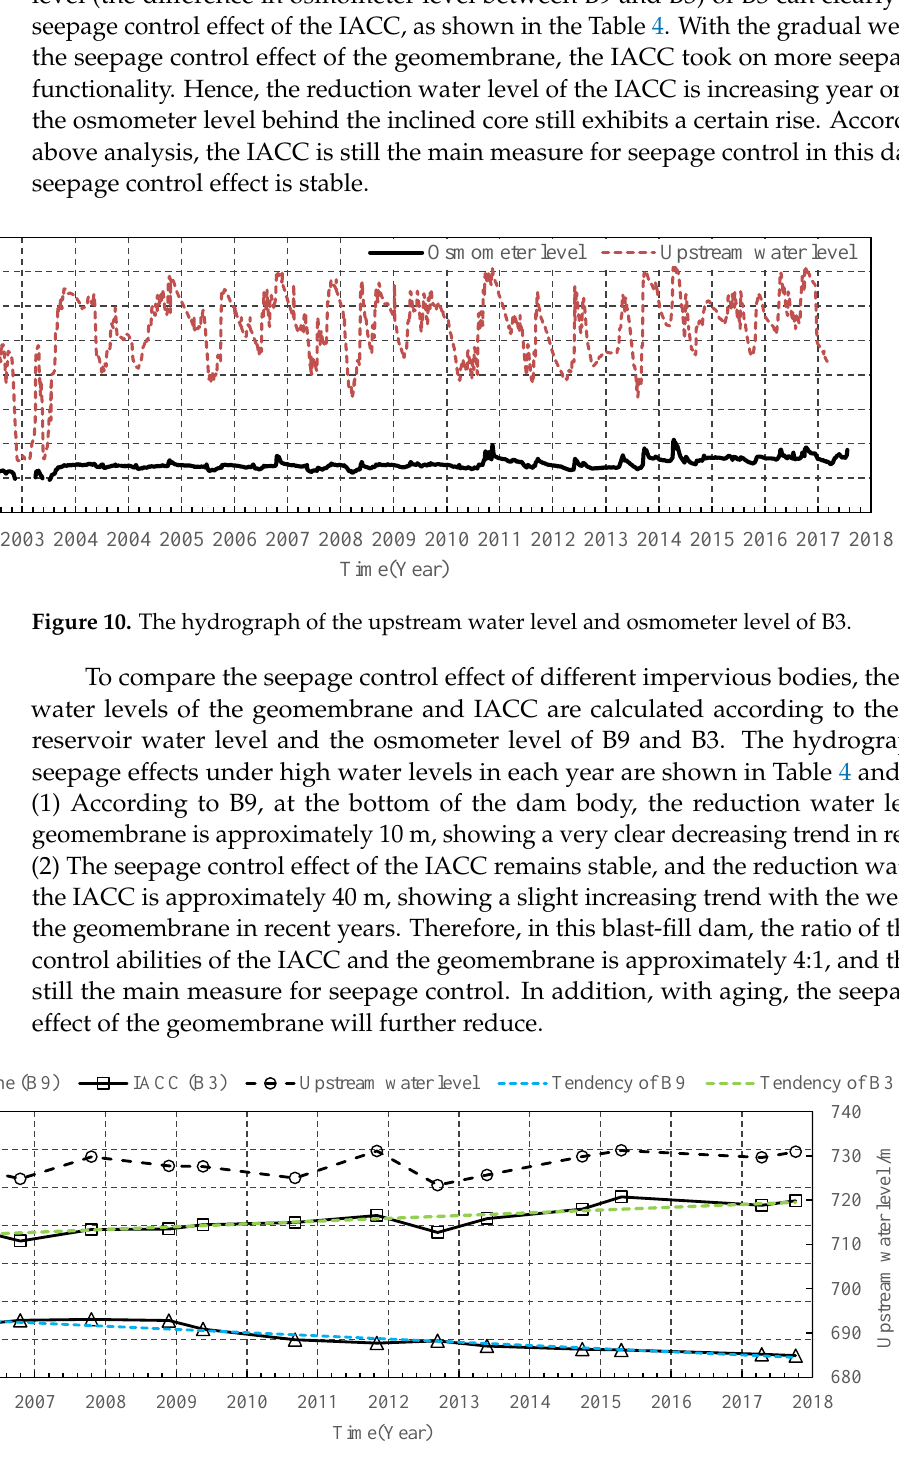
Figure 11. Comparison of the seepage control effects between the geomembrane and IACC.